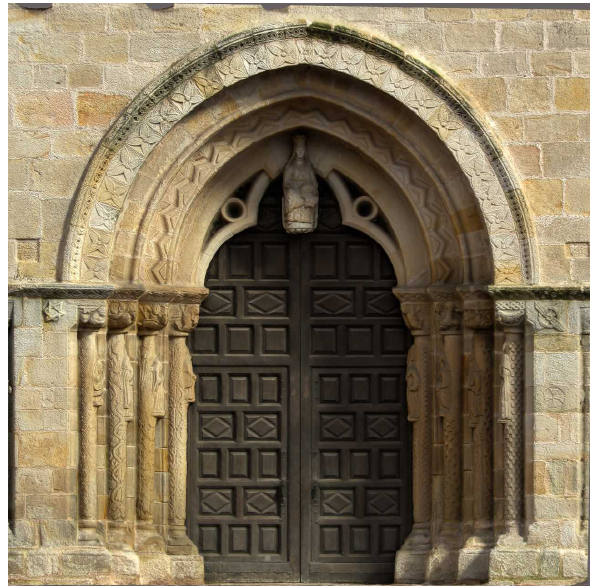
Figure 3: Ortoimage generated from the virtual model with ap- pearance capture simulating direct sunlight with partly overcast sky. Shadows are slightly less sharp than in the original